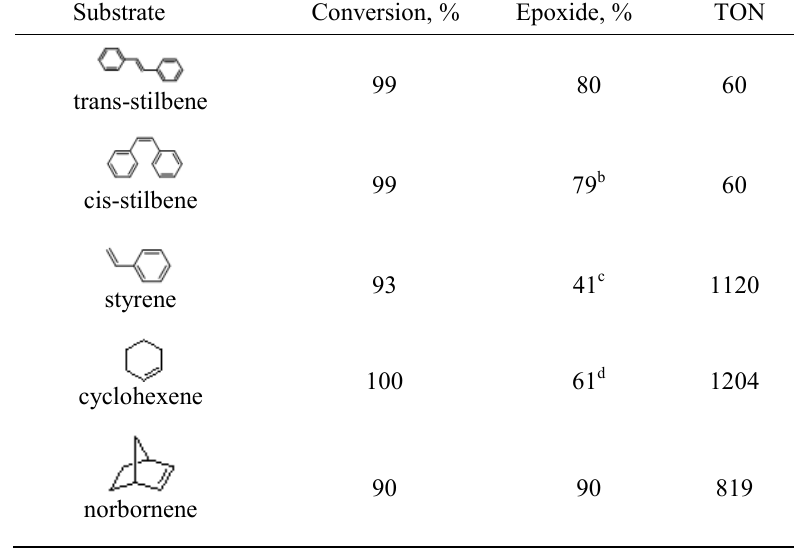
Table 3. Epoxidation results of some olefins with molecular oxygen in the presence ofCo(acac) /Al-MCM-41as 2